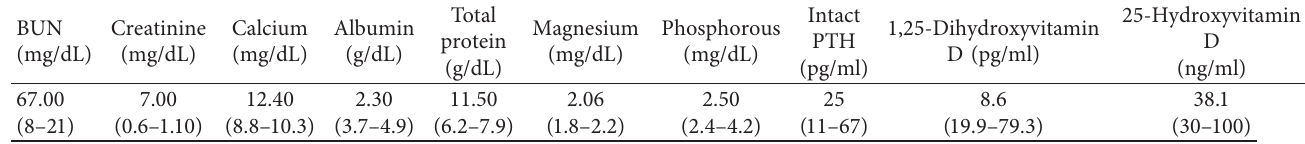
Table 1: Laboratories upon